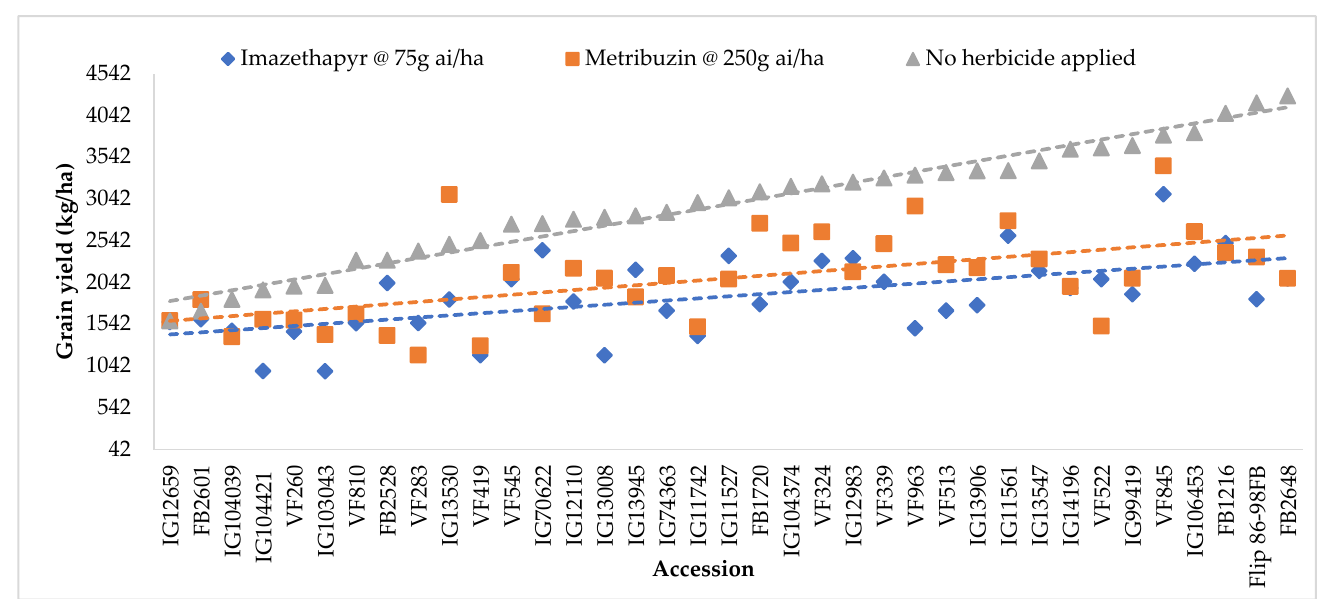
Figure 2. Mean grain yield (kg/ha) of studied accessions across seasons–locations under imazethapyr, metribuzin and no herbicide application treatments (SE = 38.76). As significant GE interactions were detected for grain yield, the grain yield stability was assessed based on the same parameters used to evaluate the plant height stability as presented in Table 6. Considering the cultivar superiority and the ability of a genotype to have an above average mean performance across environments, VF845 had the best grain yield performance in all environments. As for the ability of the genotypes to maintain a stable performance across environments FB2528 was considered the most stable based on the static stability parameter, VF810 based on Wricke’s eco-valence, as it had the lowest eco-valence value, and IG103043 based on Finlay and Wilkinson stability parameter, as they received the lowest values of these parameters. Table 6 . Cultivar superiority index, static stability, Wricke’s eco-valence and Finlay and Wilkinson values for the grain yield of faba bean accessions evaluated in 12 different environments. Values marked in bold belong to the 10 most stable accessions, while values presented between brackets reflect their ranking.